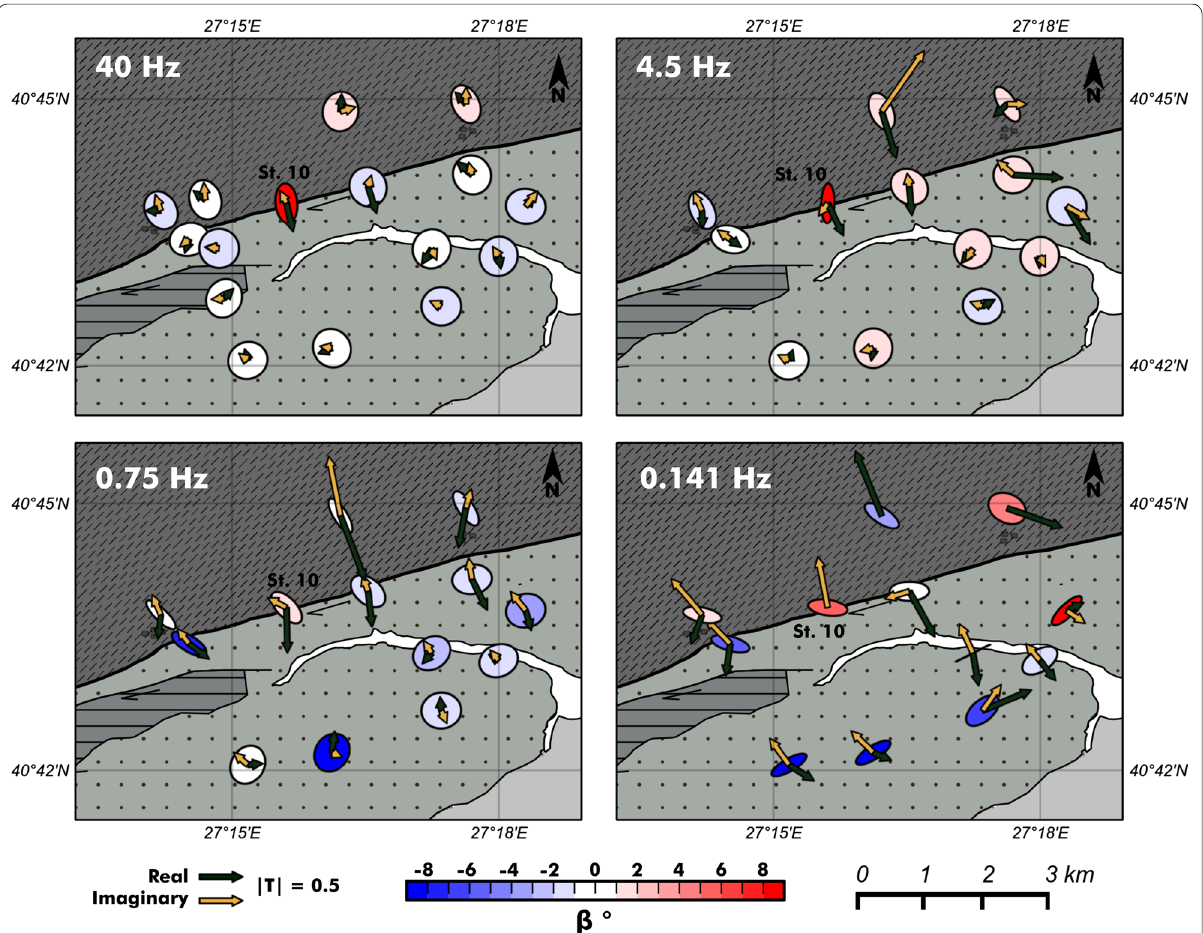
Fig. 3 Map view of the phase tensor with real and imaginary induction arrows at 40, 4.5, 0.75, and 0.141 Hz. The phase tensor ellipses were colored based on β angles, where any value other than zero is an indicator of a three-dimensional electrical structure; its degree increases as the angle takes extreme values at both